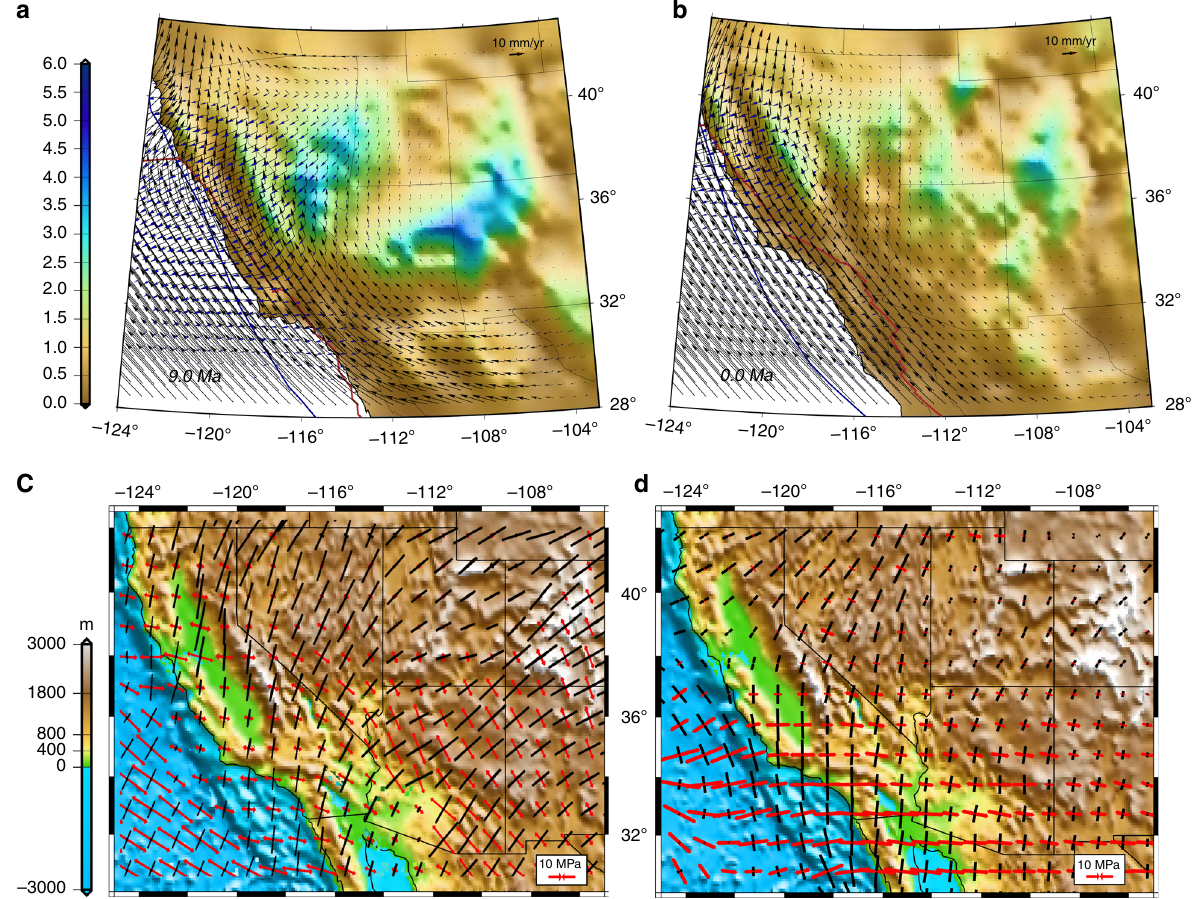
Fig. 8 Long-wavelength effect of mantle fl ow within the Basin and Range Province. a Map of ratio of T GPE / T BCS at 9 Ma. Blue vectors are velocity fi eld estimates relative to North America associated with GPE. Black vectors are boundary condition velocity fi eld estimates relative to North America; b same as “ a ” but at present-day. Red line represents reconstructed position of the East Paci fi c Rise and SAFS. Blue line represents reconstructed position of continental edge. c Deviatoric stresses from lithosphere coupling with global mantle fl ow S40RTS 46 . d Boundary condition solution of deviatoric stresses at present-day (comparison of the compressional directions and magnitudes in both models within the Basin and Range Province emphasizes the long- wavelength effect of mantle fl